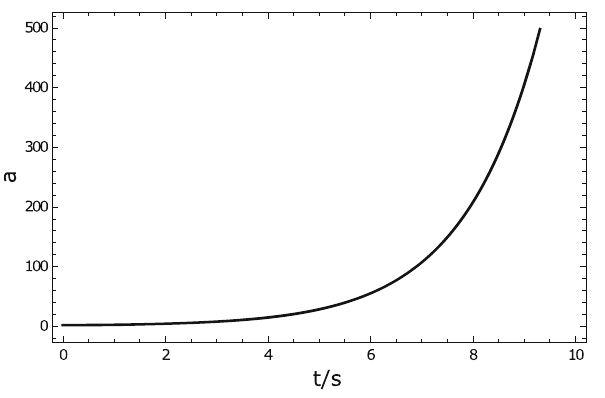
Fig. 1 Evolution of the scale factor for constant jerk parameter Eq. (25) with cosmic time, for λ = 1, A = 0 . 2 and B = − 0 . 1